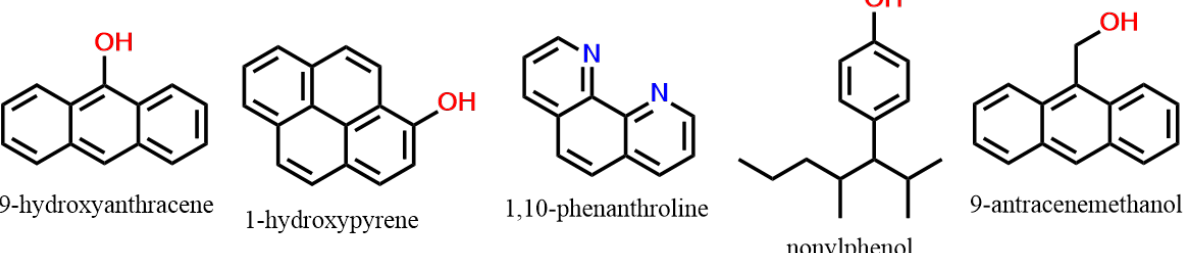
Figure 15. Molecular structures of model compounds that eluted to the Resins fraction. For simplicity, a single isomeric structure for nonylphenol is shown. (The red color indicates OH group, while the blue color designates nitrogen atom.)